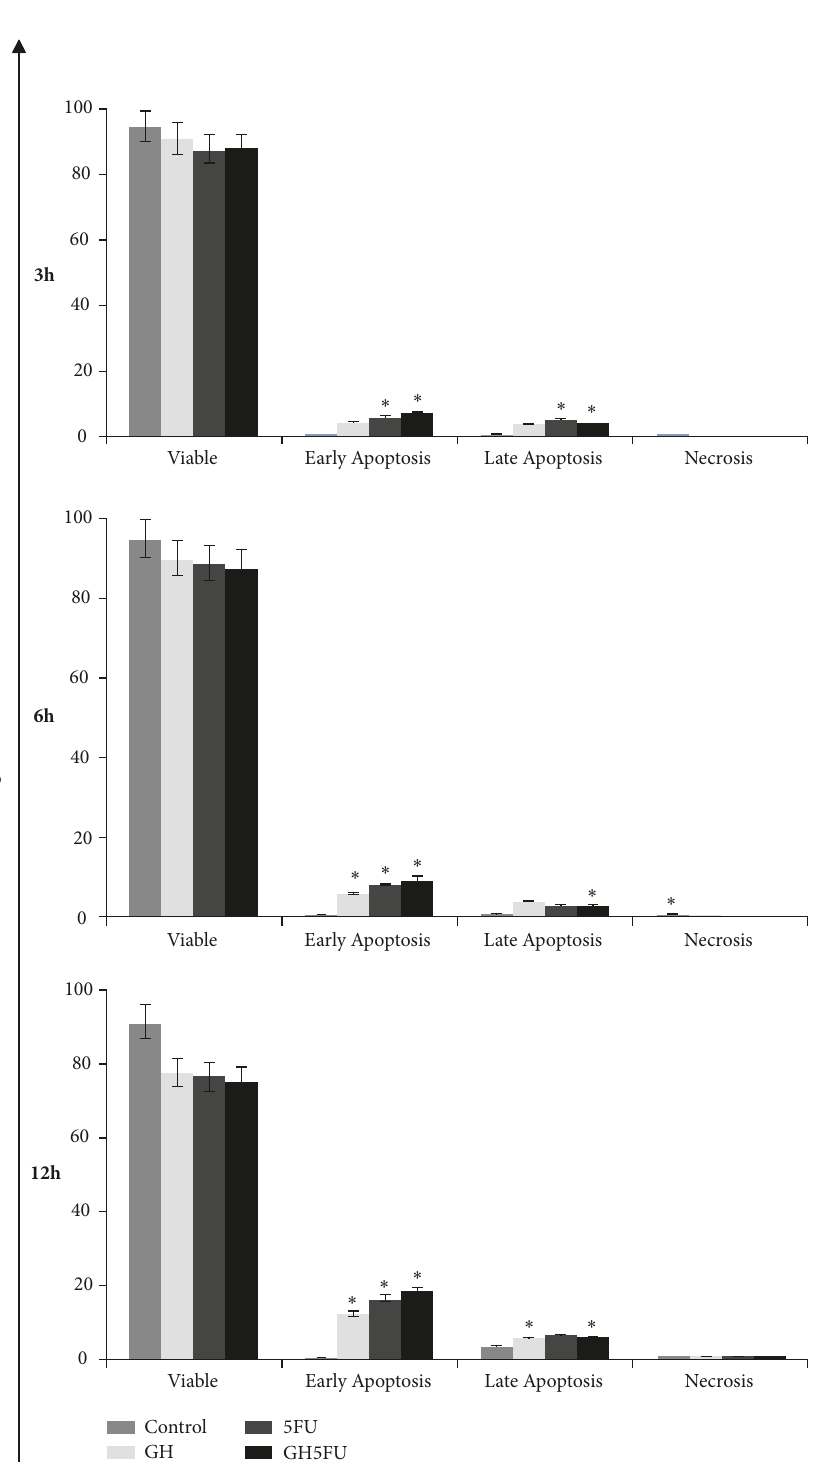
Figure 6: Analysis of phosphatidylserine externalisation in HT-29 cells via Annexin V and PI staining using a flow cytometer. Results are presentedas means ± S.E.M. of three independentexperiments. ∗ Statistical significance (P < 0.05) between control cells and